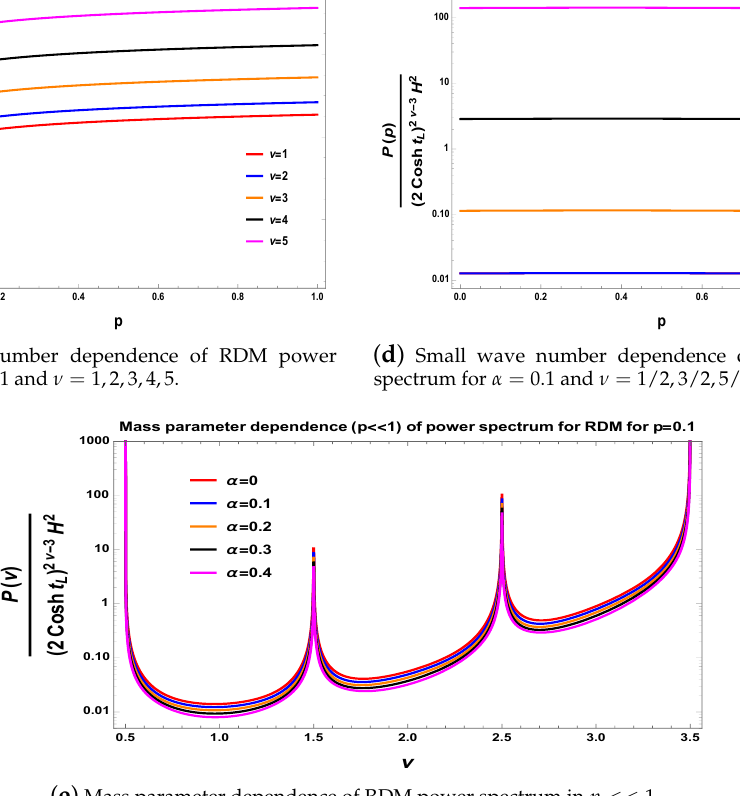
Figure 10. Features of RDM power spectrum in small wave number region. ( a ) Small wave number dependence of RDM power spectrum for α = 0 and ν = 1,2,3,4,5; ( b ) Small wave number dependence of RDM power spectrum for α = 0 and ν = 1/2,3/2,5/2,7/2,9/2; ( c ) Small wave number dependence of RDM power spectrum for α = 0.1 and ν = 1,2, 3,4,5; ( d ) Small wave number dependence of RDM power spectrum for α = 0.1 and ν = 1/2,3/2,5/2,7/2,9/2; ( e ) Mass parameter dependence of RDM power spectrum in p <<